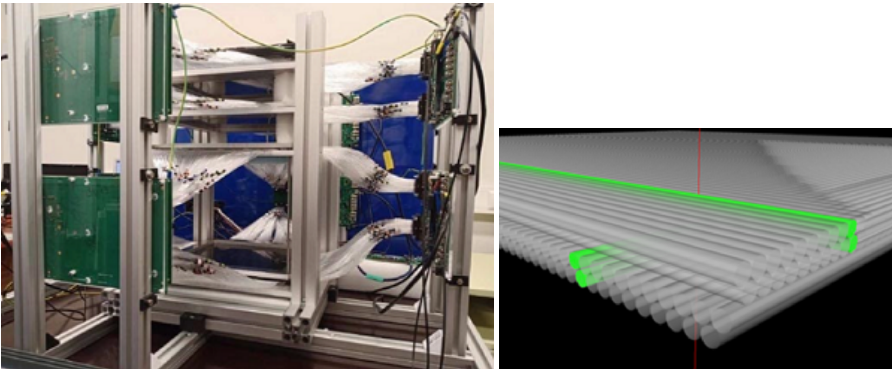
Figure 13. ( Left ): CRT system prototype based on scintillating fibre detectors; ( right ): GEANT4 model of double-fibre layers (grey cylinders). Reproduced from